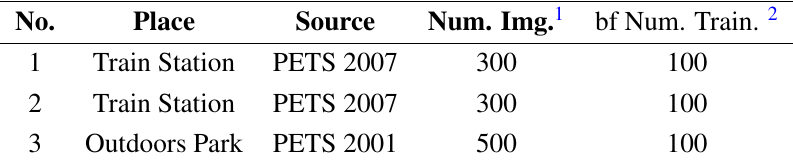
Table 3. List of sequences of images used as ground truth. These images present complex scenarios. The first two sequences represent scenarios with shadows caused by different light sources and both color and texture of skin in some frames, that are too similar to background scenario. The third one, represents a scenario with high noise degree, the reflections are caused by the windows and the moving objects are represented by small